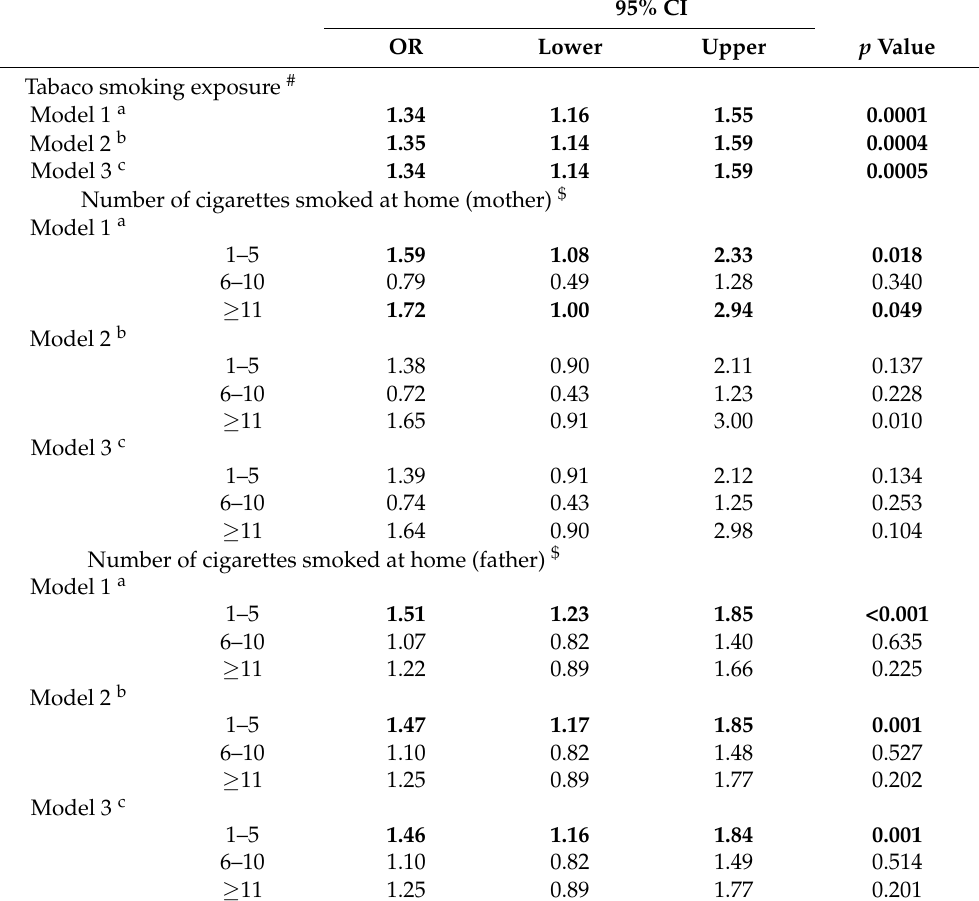
Table 2. Association of tobacco smoke exposure with vitamin D deficiency in children age 2